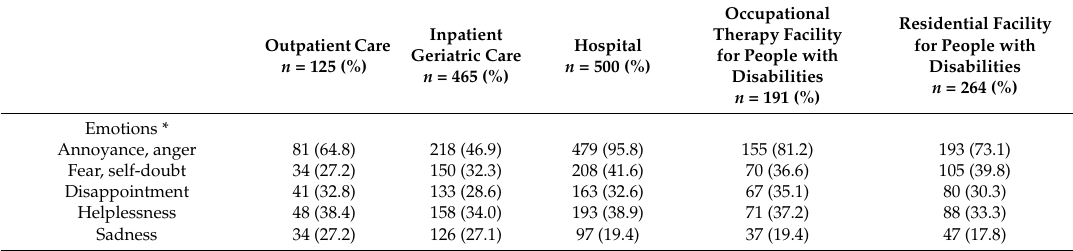
Table 4. Consequences of verbal or physical violence for the study population by area of